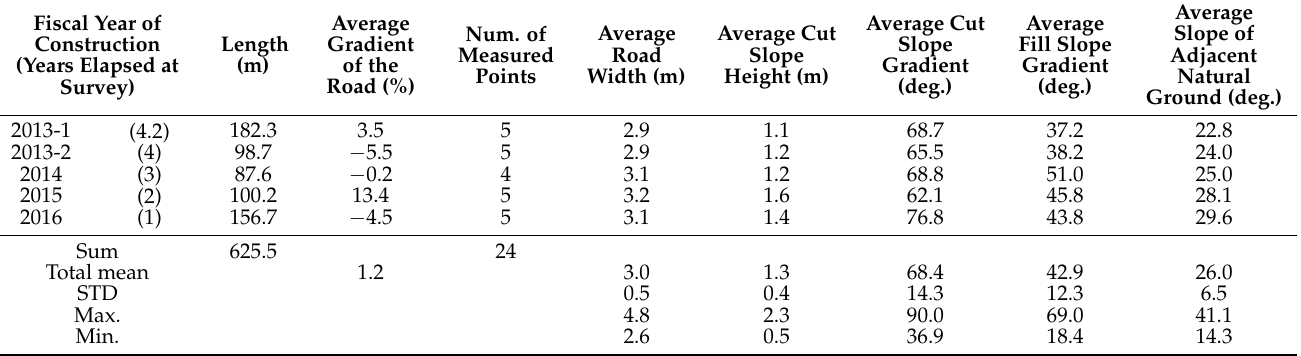
Table 1. Descriptive statistics of Study Site 1: a spur road in the west block of Kochi University Forest.